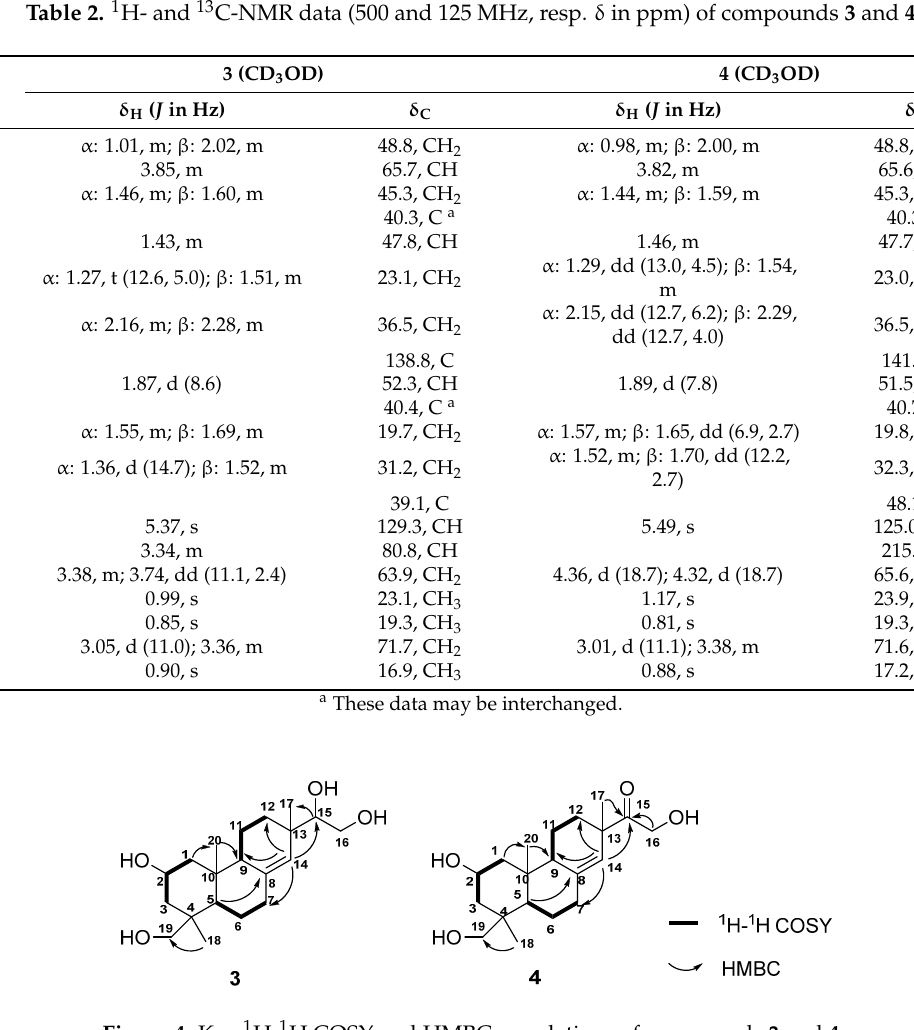
Figure 4. Key 1 H- 1 H COSY and HMBC correlations of compounds 3 and 4 .